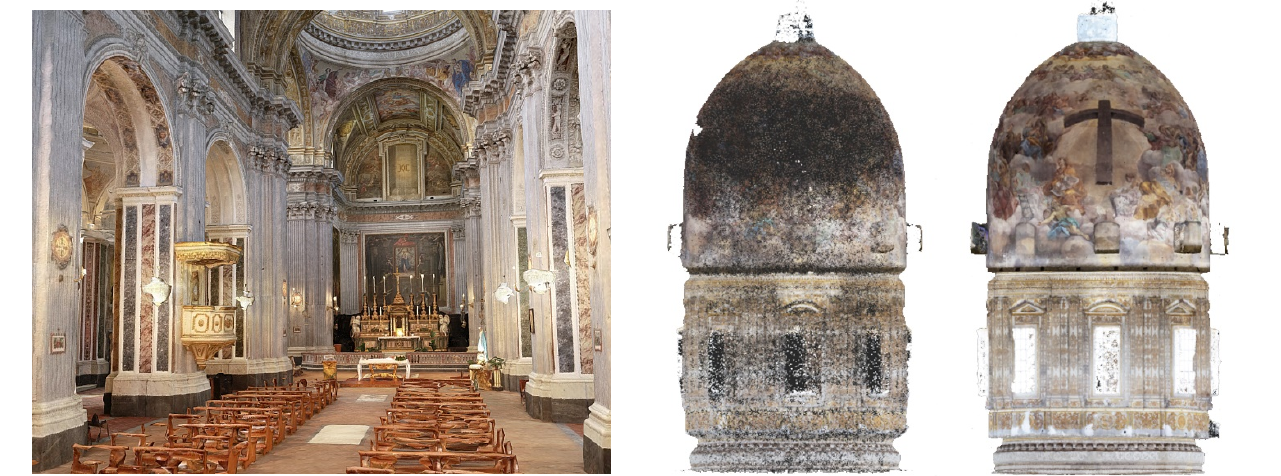
Figure 8. Texturized polygonal model: view of the apse area from the central